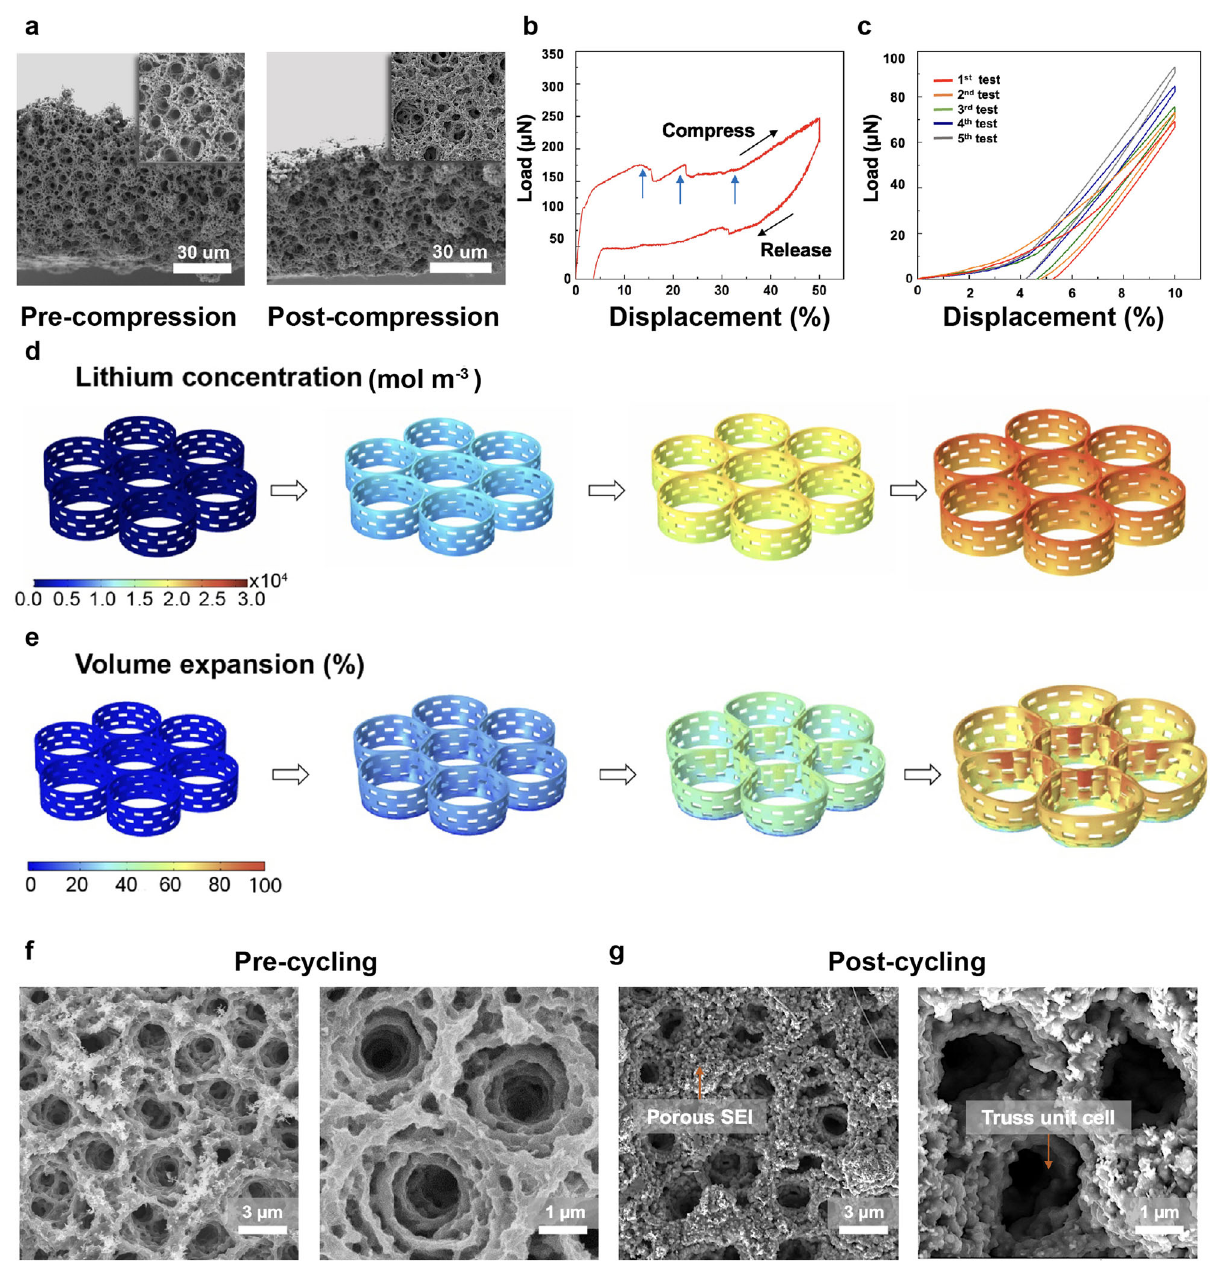
Fig. 3 | Structural stability and capacity retention of MoS 2 foam. a SEM images of pre- (left panel) and post-compression (right panel) of MoS 2 foam to 50% of displacement demonstrate an excellent recovery behavior. b The load and dis- placement curve (displacement to 50%) displays a ductile-like feature with con- tinuous serrated fl ow (gray arrows), attesting to the multistep deformation of the hierarchical structure. c The load and displacement curve (displacement to 10%) exhibits a resilient feature with great recoverability. d Li-ion diffusion and the